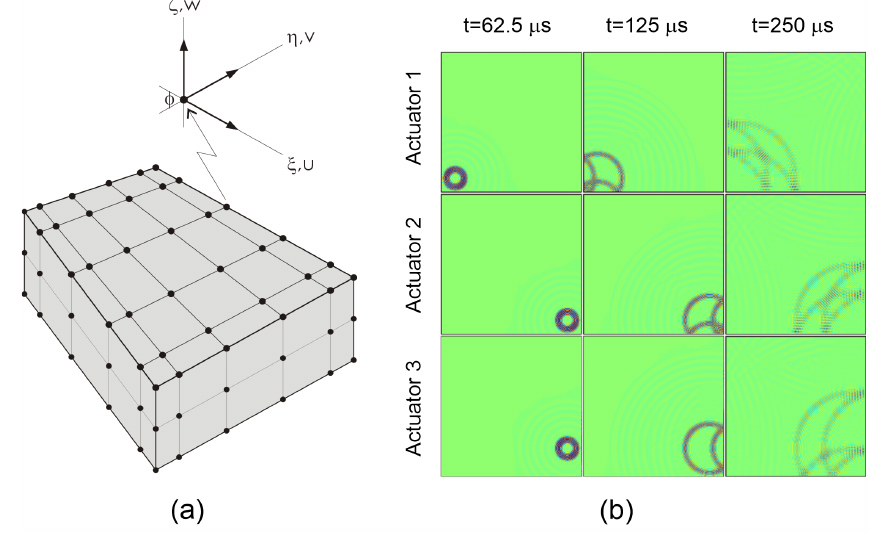
Figure 5. ( a ) Modeling approach showing 3D spectral element with three nodes across the thickness; ( b ) Wave propagation patterns at selected times propagating from Actuator Nos. 1, 2, and 3,